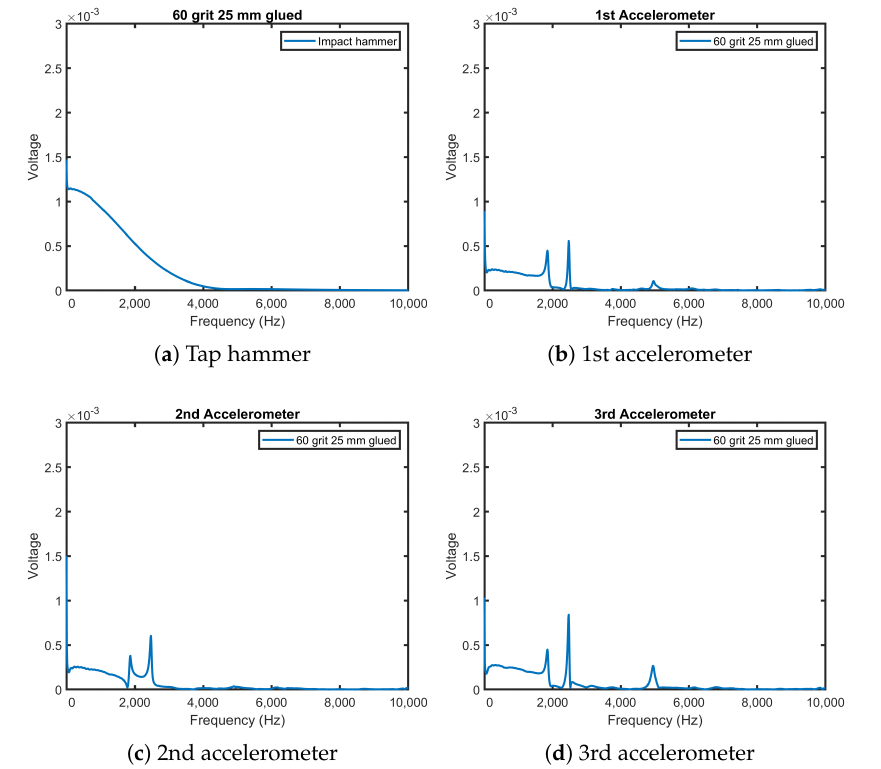
Figure 15. Typical natural frequency result of the 25 mm glued 60 grit